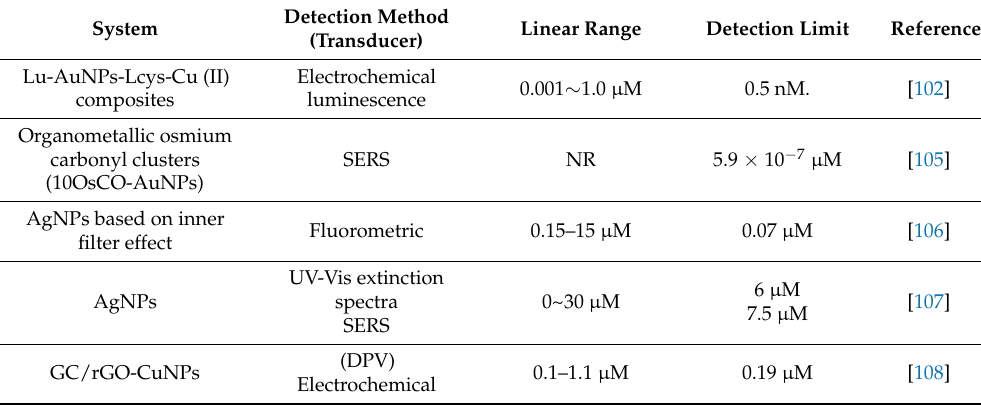
Table 2. The 0D-nanomaterial metal-based nanoparticles as GLYP detection